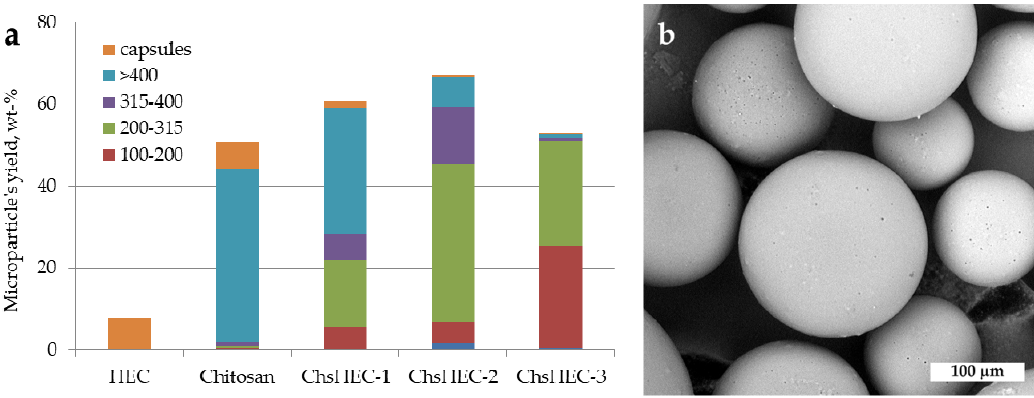
Figure 4. ( a ) Histogram of microparticle’s total yield and size distribution as a function of polymer used as an emulsifier in the aqueous phase; ( b ) micrograph of polylactide microparticle stabilized with 1 wt % aqueous solution of ChsHEC-2.